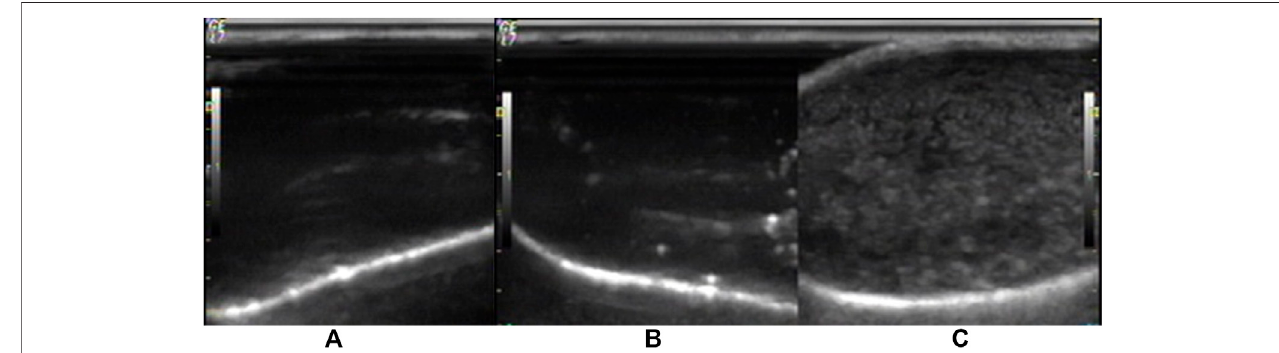
Figure 7 | Representative in vitro ultrasonic images. (A) Saline, (B) ultrasonic medicinal coupling gel, (C) nanobubbles under high-frequency diagnostic ultrasound in latex gloves mold.